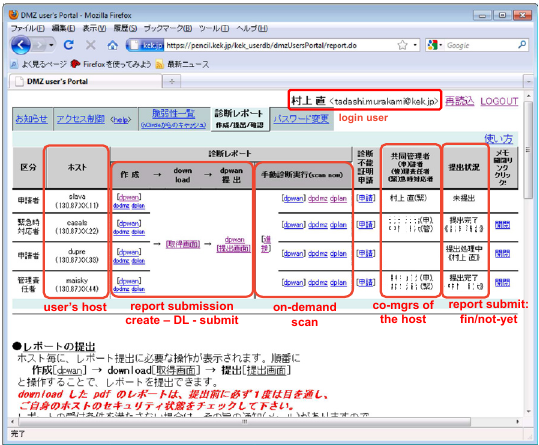
Figure 2: Main page of DMZ User’s